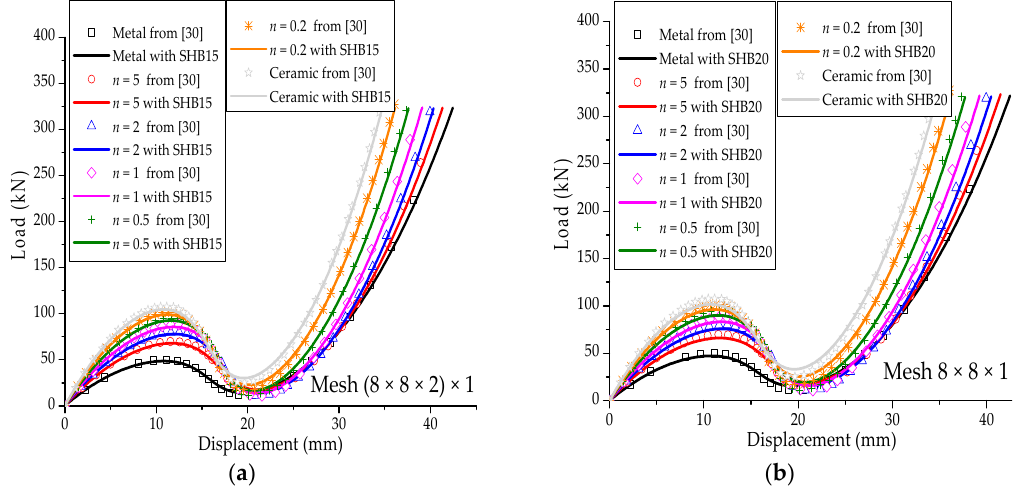
Figure 12. Deflection at the central point A under concentrated force for the thick hinged roof. ( a ) prismatic SHB15 element; ( b ) hexahedral SHB20 element.